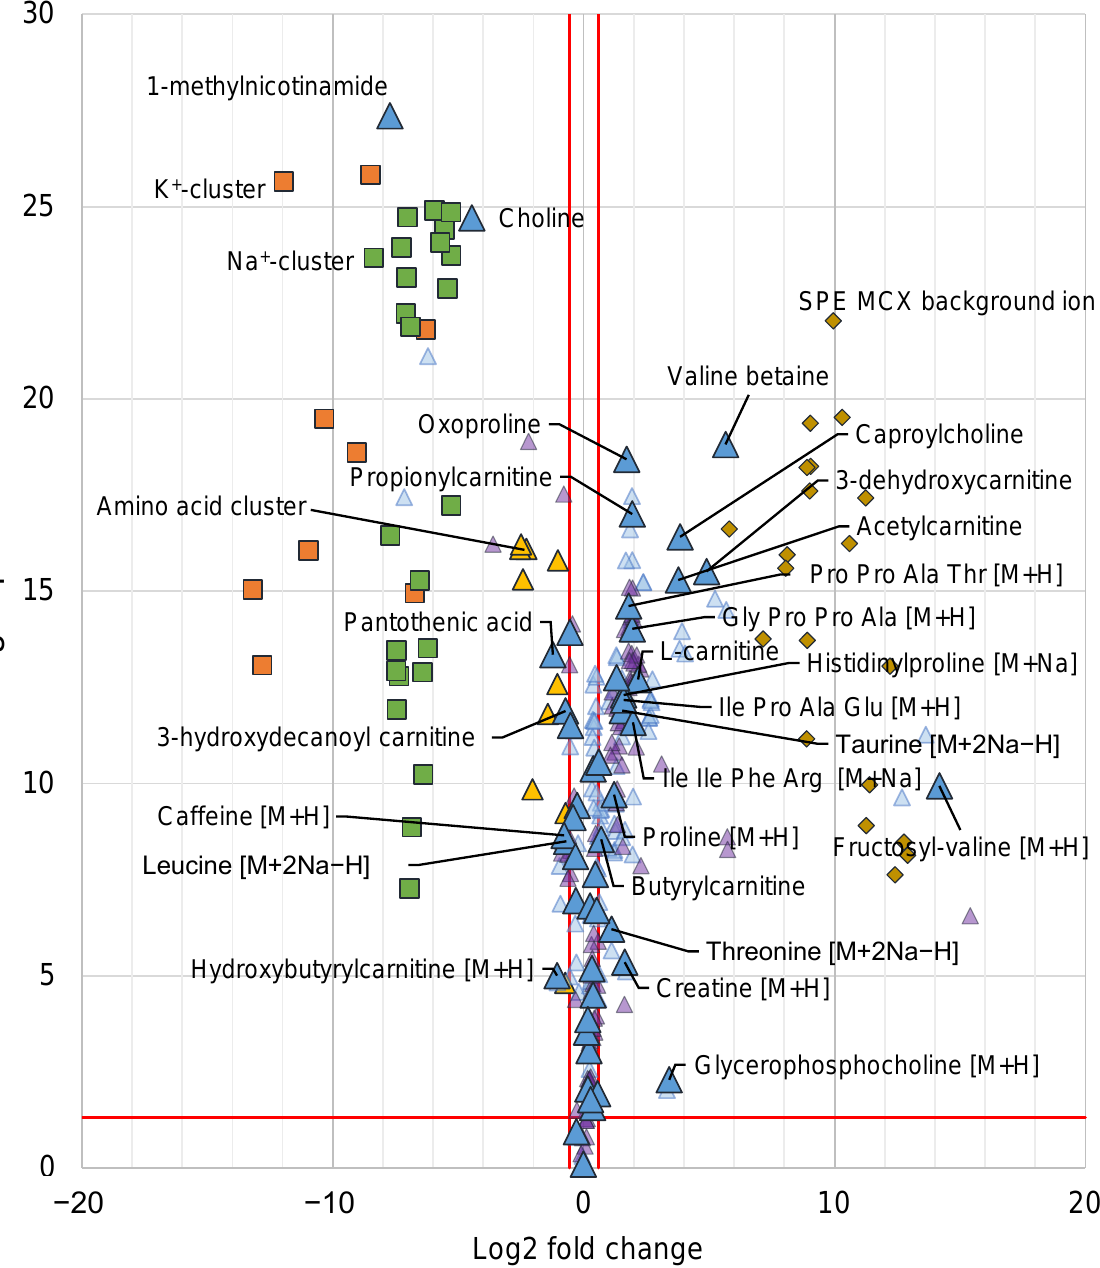
Figure 6. Volcano plot with all annotated features from the multivariate data analysis, indicated as differentiating between the SPE MCX and PPT samples. X-axis shows log2 fold change and the y-axis -log10 p -value from a unpaired t -test. A positive log2 fold change indicates higher intensity in the SPE MCX samples and negative log2 fold change indicates a higher intensity in PPT samples. Metabolites are denoted by triangles, for each annotated metabolite the [M+H] + or corresponding signal is denoted by a large blue triangle (depending on which ions were detected), fragment ions or isotopes are denoted by smaller light blue triangles, adducts are denoted by small purple triangles. All metabolites with a fold change corresponding to 1.5 or more and a p -value < 0.05 (indicated by red lines) are labelled with their respective annotation. K + clusters (K + (HCOOK) n ) denoted by orange squares ( ), Na + clusters (Na + (HCOONa) n ) are denoted by green squares ( ), clusters containing amino acids are denoted by yellow triangles ( ). Background ions from the SPE cartridges are denoted by dark yellow diamonds ( ). All annotated features can be found in supplementary data Tables S5 and S6.